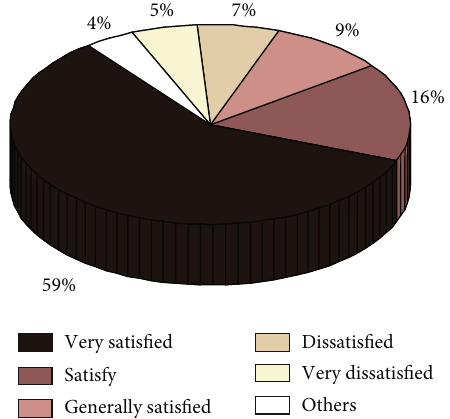
Figure 6: Evaluation of the e ff ect of the masses on the image recognition discovery of the partial di ff erential equation wavelet transform of the large-scale linkage